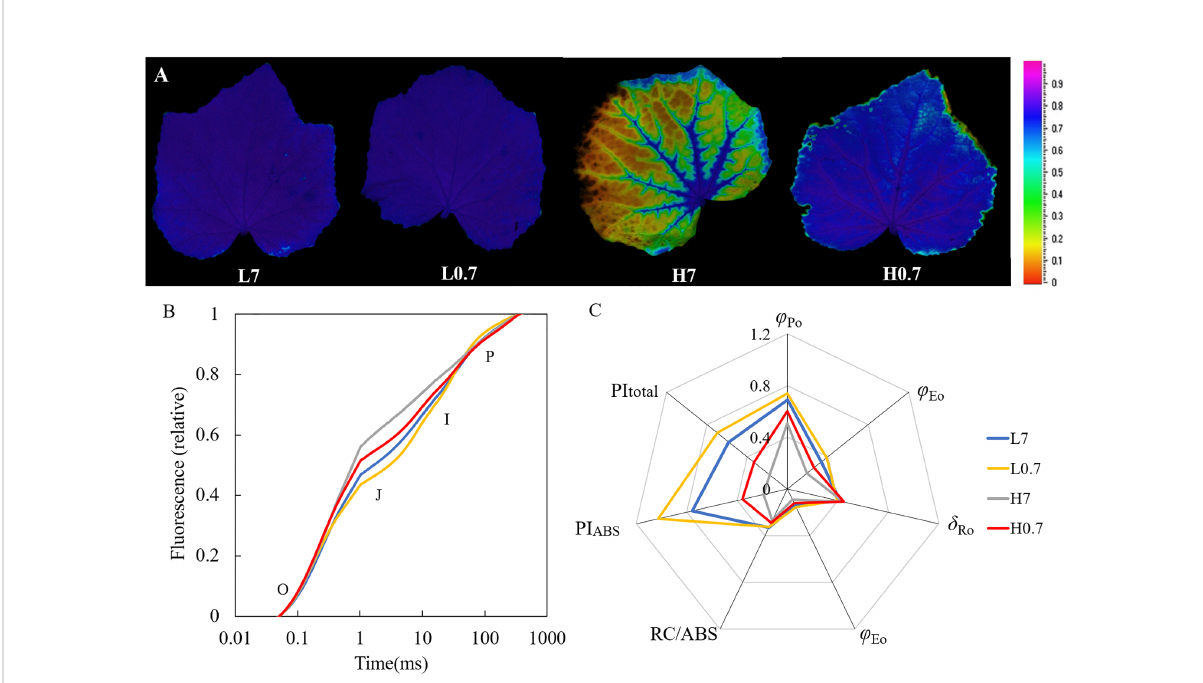
FIGURE 4 Effect of R/FR on chlorophyll fl uorescence parameters in cucumber leaves under salt stress. (A) , maximal photochemical quantum yield of PSII ( F